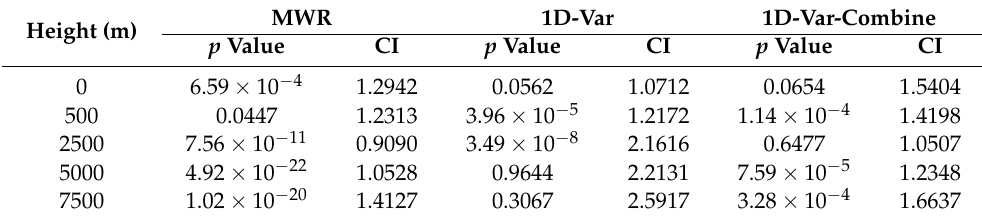
Table 2. Statistical significance in temperature profiles in the cloudy